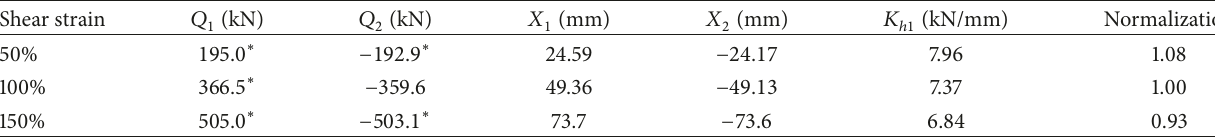
Table 4: Test results of 𝐾 ℎ1 in different shear strain.